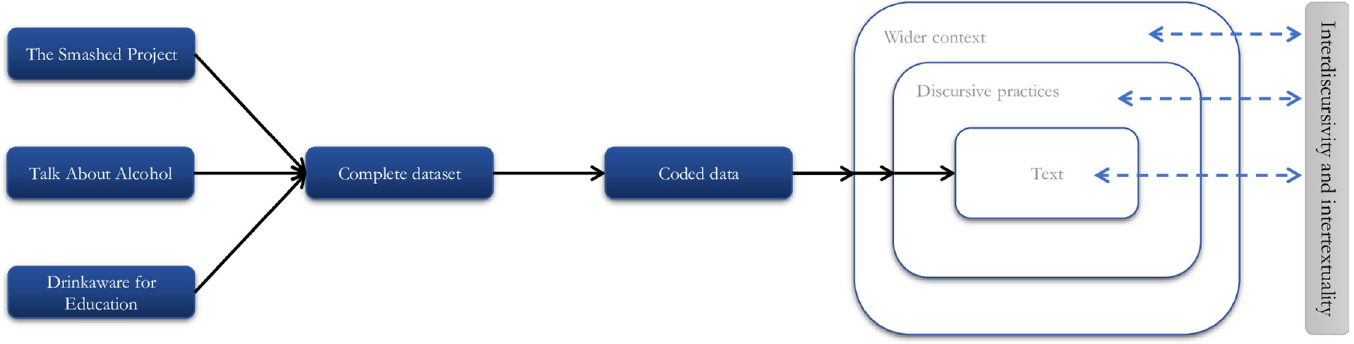
Fig 1. Schematic representation of the analytical